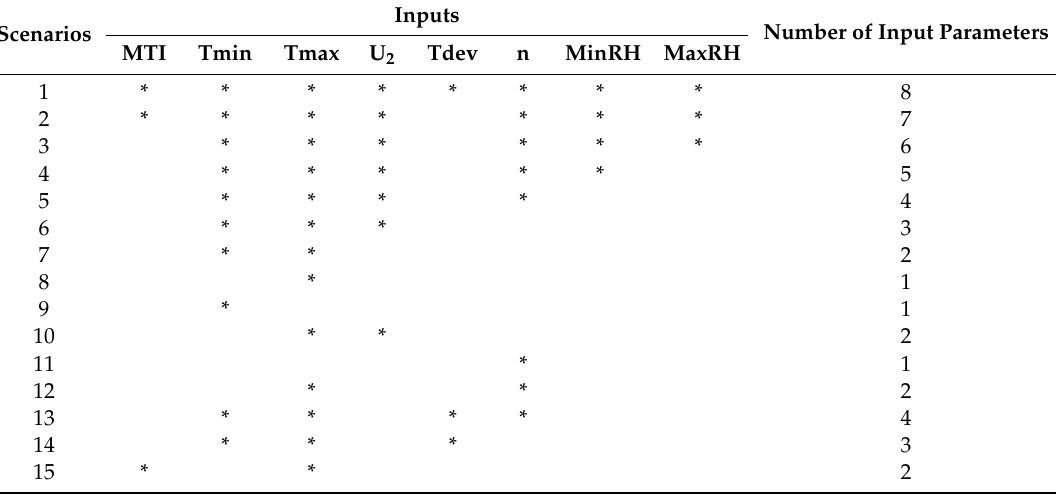
Table 3. Alternative scenarios.